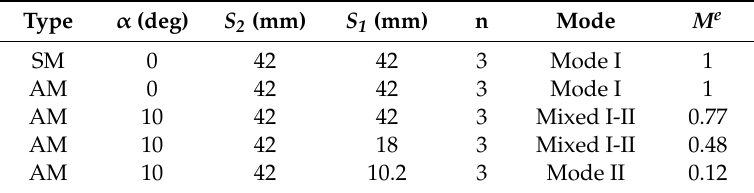
Figure 2. Micrographs of the crack tip; ( a ) crack-like notch manufactured during the additive manufacturing process (AM) and ( b ) crack induced by subtractive manufacturing (SM) and subsequent pre-cracking (indicated by red arrows). Table 2. Values of the geometrical parameters of the specimens tested.